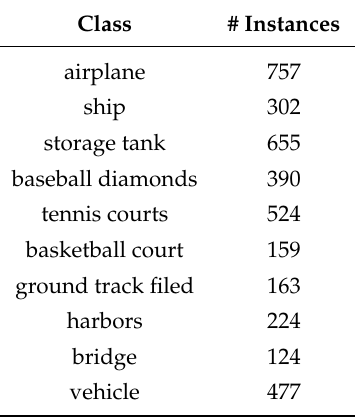
Table 1. Statistical information about NWPU VHR-10 dataset. This dataset has been divided into 60% training set, 10% validation set, and 30% testing